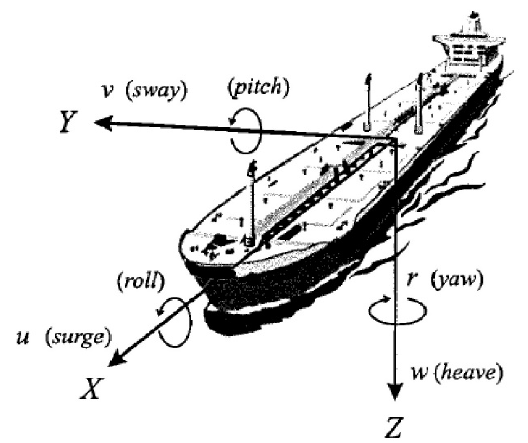
Figure 2. A representation of the variables of an autonomous surface vehicle (ASV).